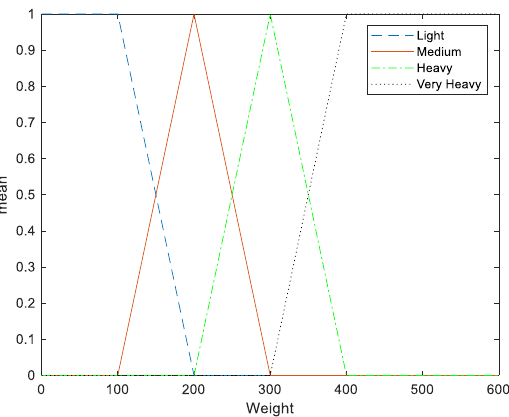
Figure 14. Membership functions of angle.